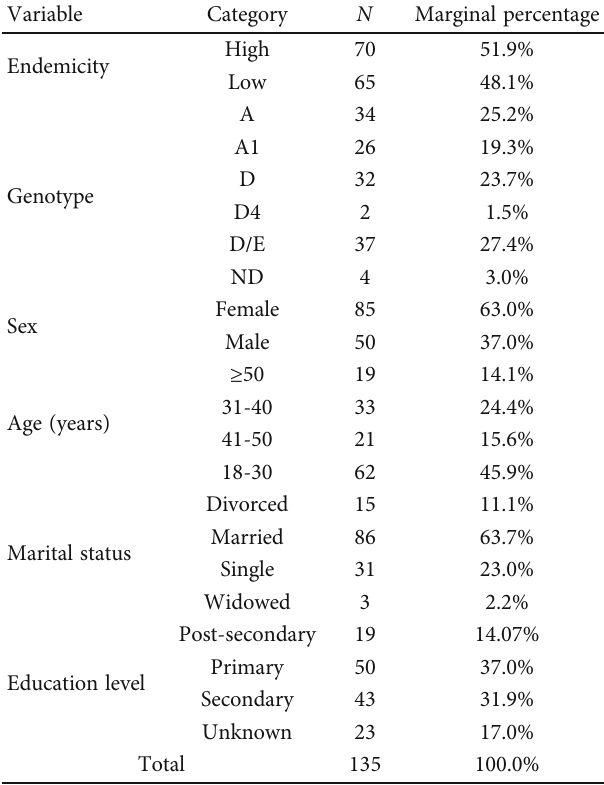
Table 1: Sociodemographic characteristics of study participants in a low and high endemic region with detectable HBV